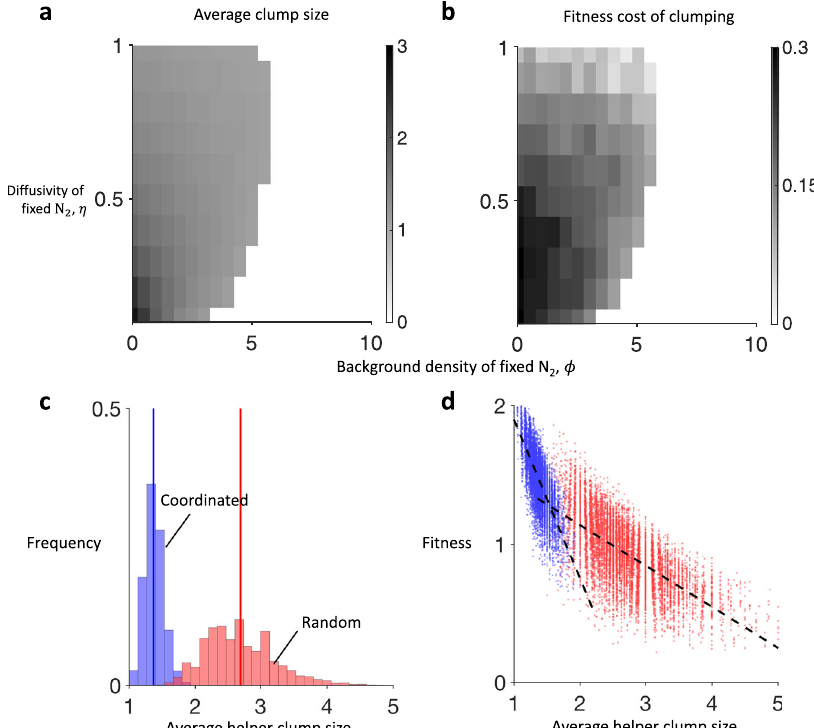
Fig. 6 Spatial structure and helper clumping. In randomly specialising fi laments, a smaller background density of fi xed N 2 (smaller ϕ ) and more limited diffusion of helper- fi xed N 2 (smaller η ), lead to fi laments with: a a larger average clump size, measured as the average numberx of helpers per clump; and b a higher fi tness cost of clumping, measured as the slope of the least-squares linear regression of relative fi tness on average clump size. We constructed a , b by performing 1000 independent simulations of growing fi laments for each parameter combination, where the trait values are set to the associated optima for random specialisation determined in the previous analysis ( q ¼ q (cid:3) ; s ¼ 0 ; d ¼ 0 ; and v ¼ 0). We then performed 5000 independent simulations of both coordinated (blue) and random (red) fi lament growth at the extreme case of essential cooperation ( ϕ ¼ 0) and very limited diffusion of fi xed N η ¼ 0 : 1). c Coordination leads to a dramatic reduction in average clump sizes across fi laments (average clump size for random (red): 1.4 helpers 2 ( and coordinated (blue): 2.7 helpers). d The absolute fi tness cost of larger clumps is greater for coordination specialisation (blue) than for random specialisation (red) but fi laments that pay the higher cost of coordination are rare. Slope of least-squares linear regression for random: − 0.30 and coordinated: − 1.1. Mean squared error of fi t for random: 0.033 and coordinated: 0.019. Source data for panels c and d are provided as a Source Data fi le. Further details are given in Methods: The effect of helper